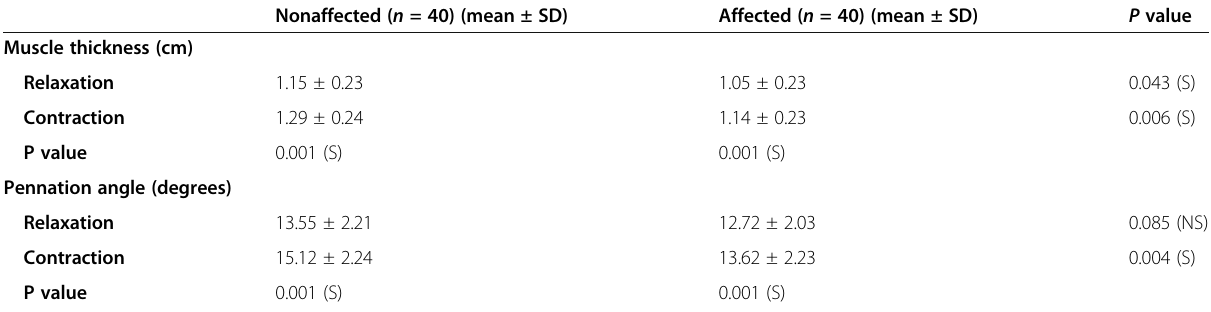
Table 2 Comparison between the mean values of muscle thickness and pennation angle (relaxation and contraction) in the two examined sides and in each side